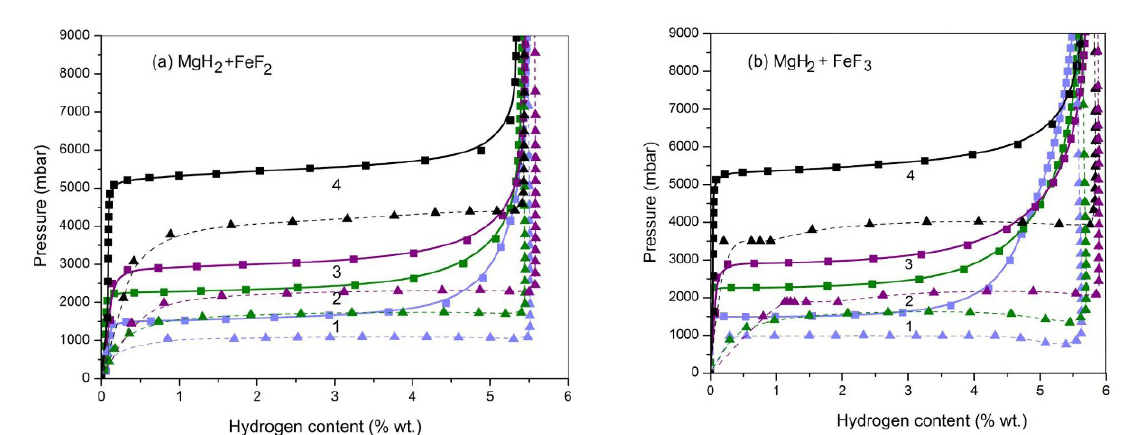
Figure 4. P-C-T isotherms of MgH milled with (a) FeF and (b) FeF additives obtained at various temperatures, where: 1-300ºC, 2-315ºC, 3-325ºC 2 2 3 and 4-350ºC. Absorption – solid line; desorption – broken